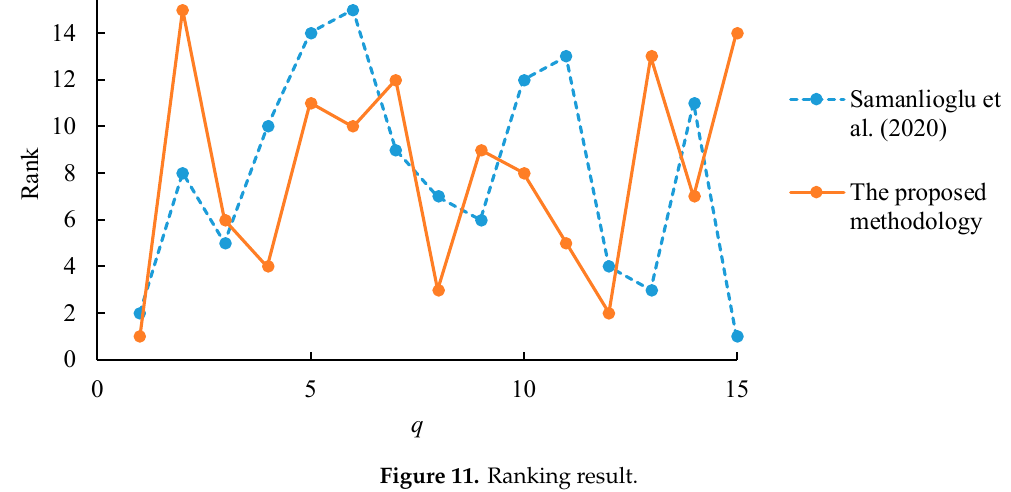
Figure 11. Ranking Figure 11. Ranking result.